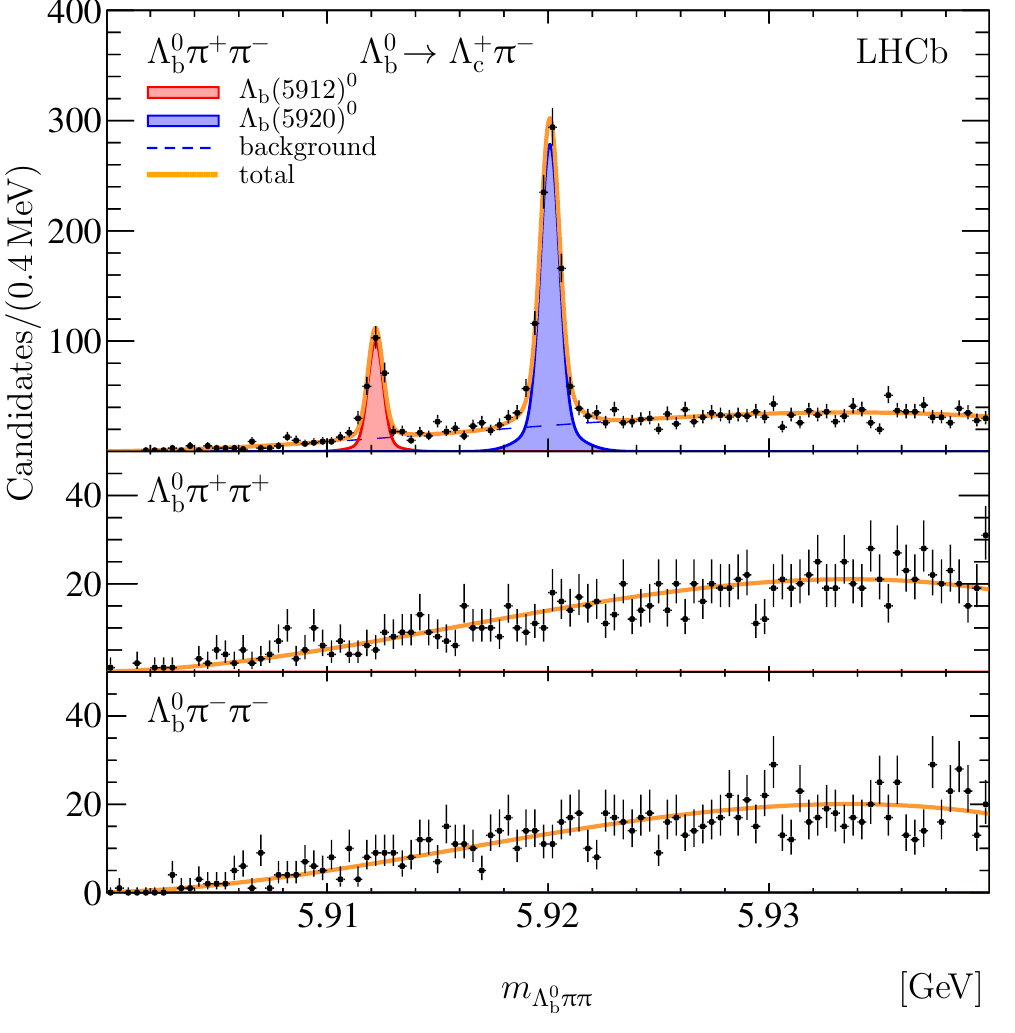
Figure 5 . Mass spectra of selected (top) (cid:3) 0